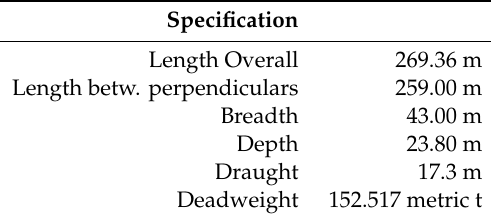
Table 1. Specification of the target vessel.